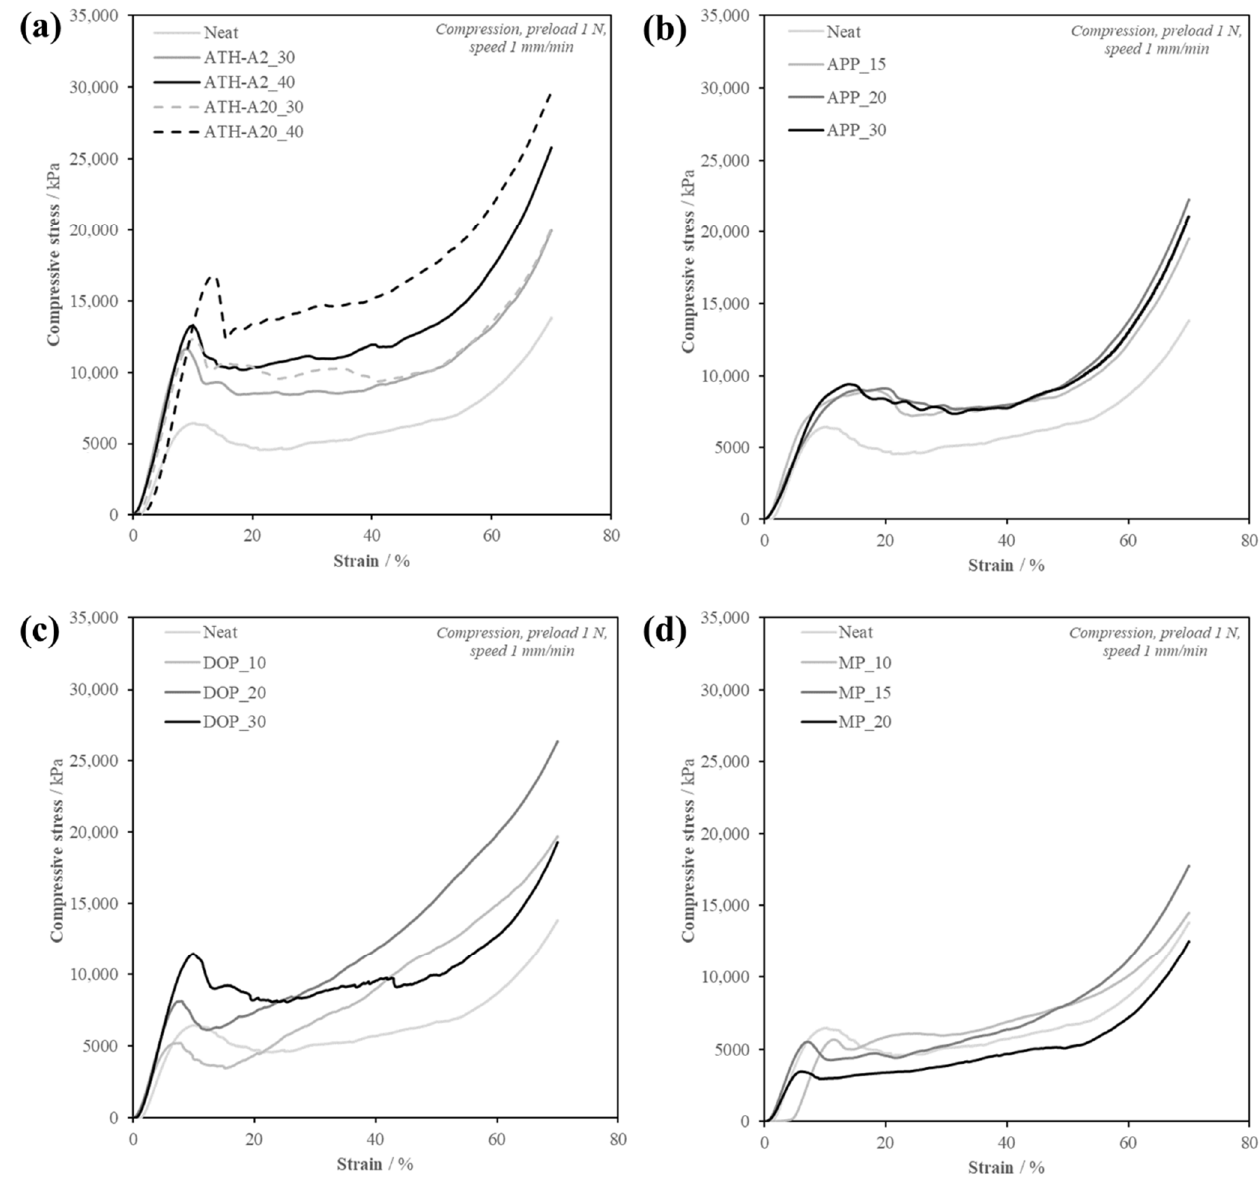
Figure 3. Compression curves of EP foams modified with ATH ( a ), APP ( b ), DOPO ( c ) and MP ( d ).